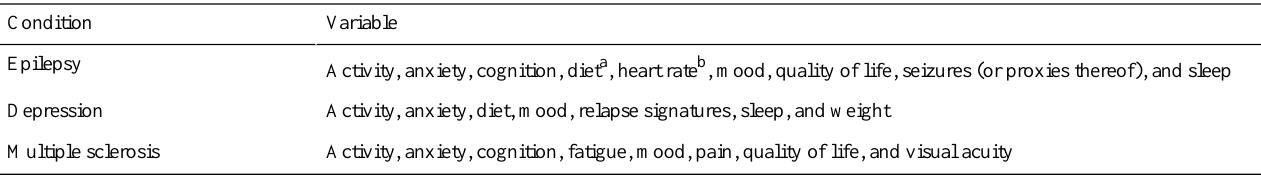
Table 2. Target variables considered potentially useful to measure using remote measurement